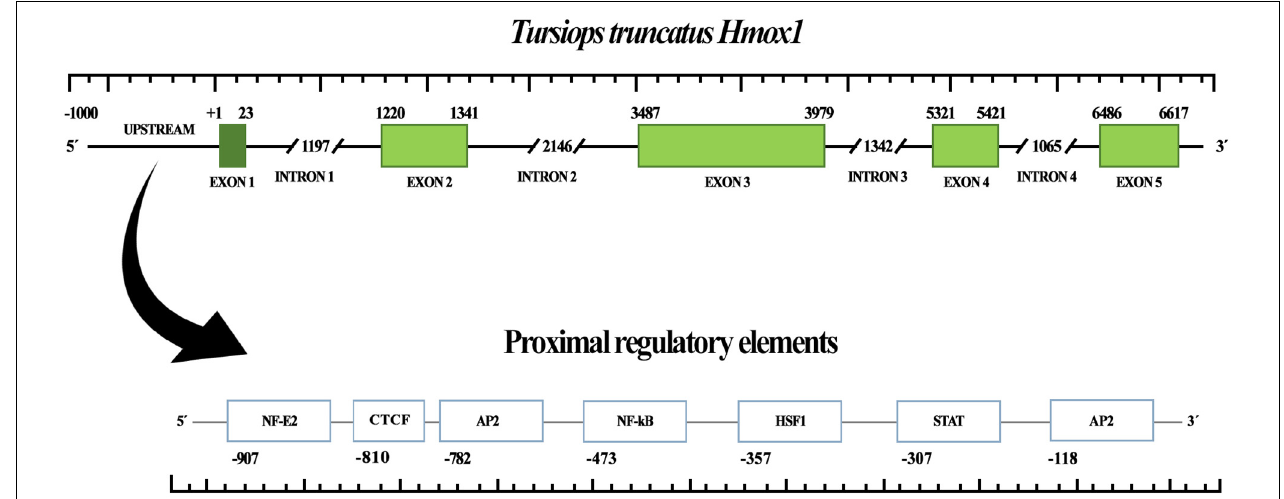
FIGURE 1 | Heme oxygenase 1 gene ( hmox1 ) structure of bottlenose dolphin ( Tursiops truncatus ). Upstream region, exons, and introns are shown. Exons/introns boundaries were obtained from Ensembl. Proximal regulatory elements are shown.